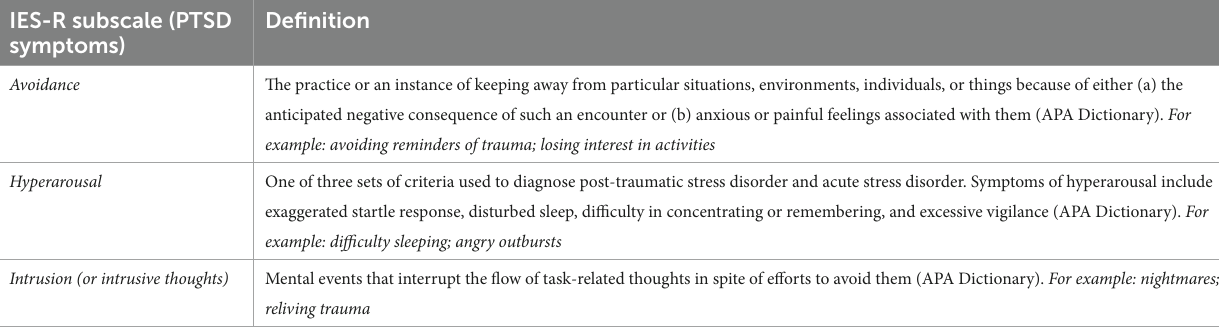
TABLE 1 Impact of Event Scale-Revised (IES-R) subscale